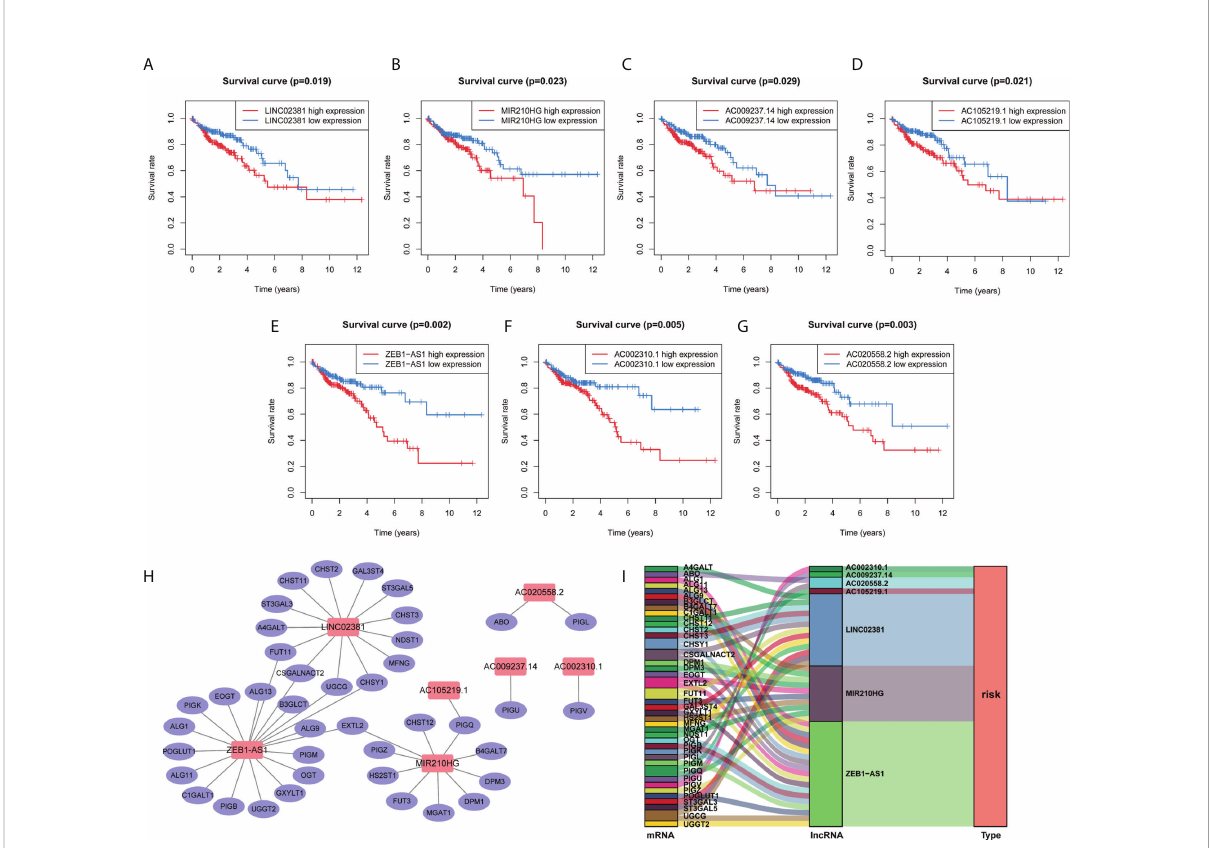
FIGURE 3 Kaplan – Meier survival curve of the selected GT-related lncRNAs and co-expression network between lncRNA and mRNA. (A – G) The overall survival curve of LINC02381, AC002310.1, ZEB1AS1, AC020558.2, AC105219.1, MIR210HG, and AC009237.14 of COAD patients in the high- and low-risk groups. (H) Co-expression network of GT genes and prognostic lncRNAs. Red nodes represent GT-related lncRNAs, while blue nodes represent GT genes. (I) The relationships among GT genes, GT-related lncRNAs, and risk type in the Sankey